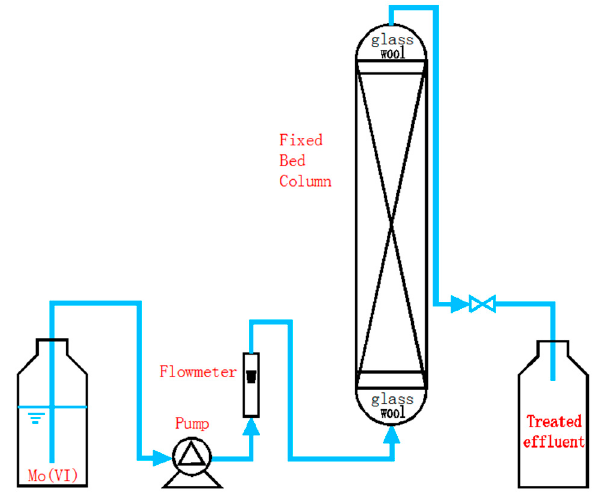
Figure 1. Experimental setup for column tests.